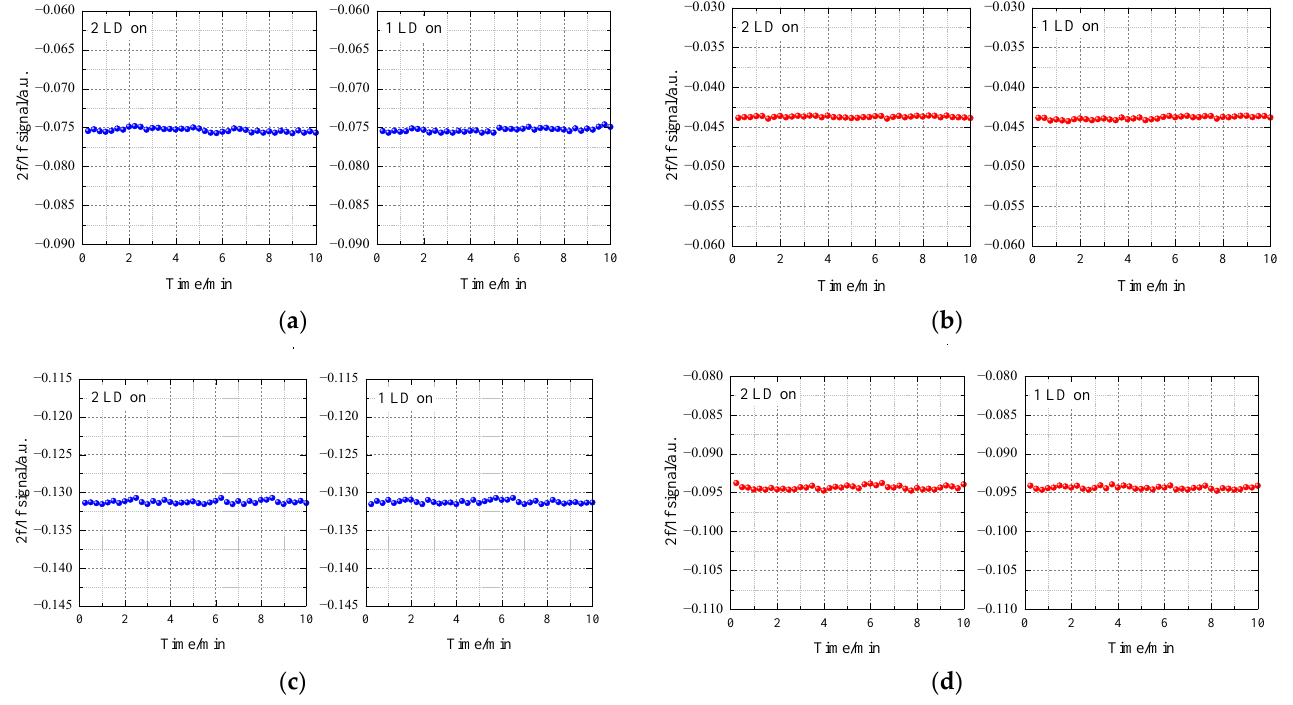
Figure 10. Detection results with and without FDM technique: ( a ) 2f/1f signal for CH4 detection (5 ppm CH4/5 ppm HCl gas mixture).; ( b ) 2f/1f signal for HCl detection (5 ppm CH4/5 ppm HCl gas mixture).; ( c ) 2f/1f signal for CH4 detection (2 ppm CH4/4 ppm HCl gas mixture).; ( d ) 2f/1f signal for CH4 detection (2 ppm CH4/4 ppm HCl gas mixture).